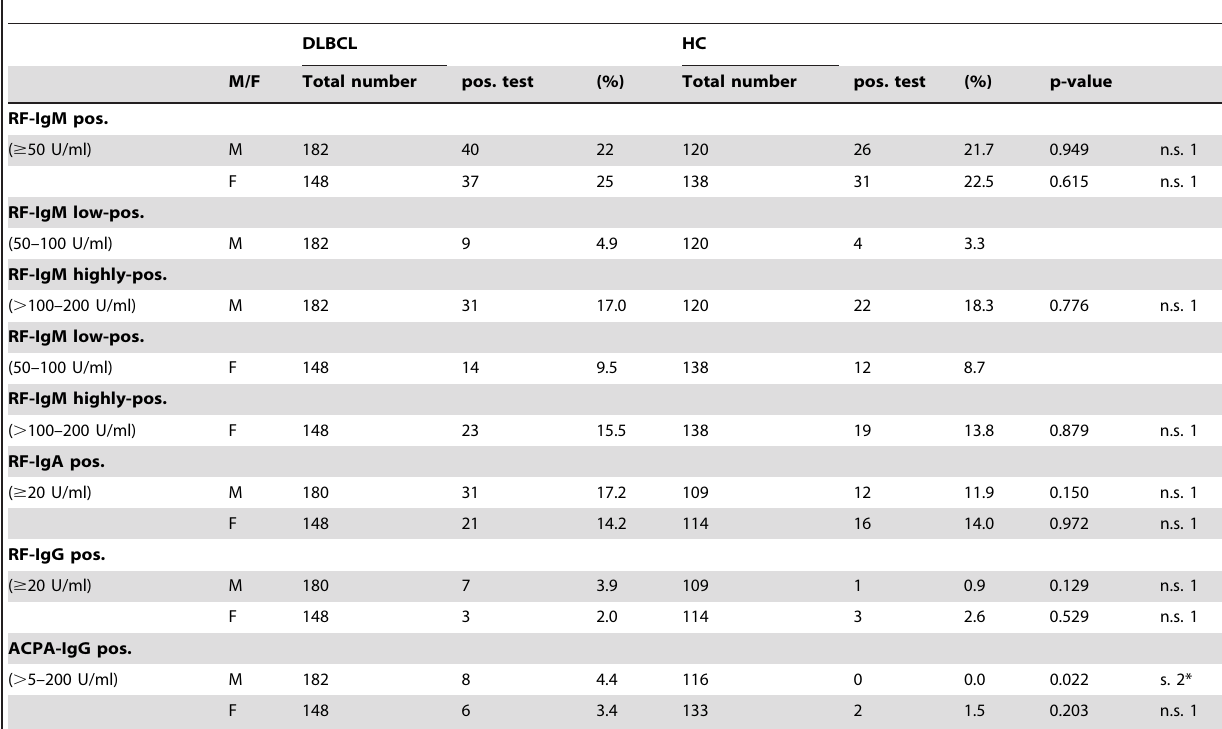
DLBCL=diffuse large B-cell non-Hodgkin lymphoma patients. HC=healthy controls.